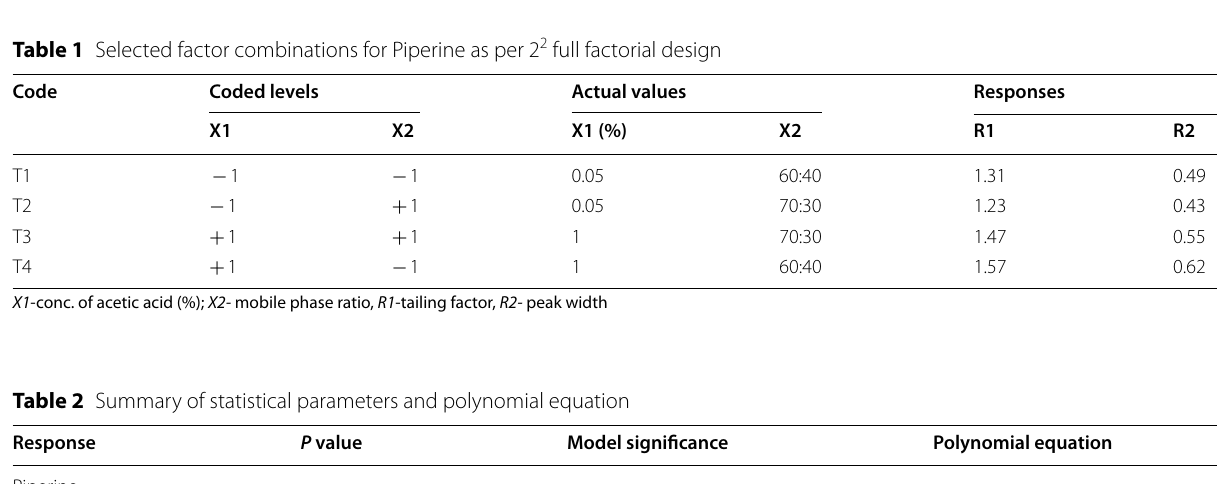
Table 1 Selected factor combinations for Piperine as per 2 2 full factorial design